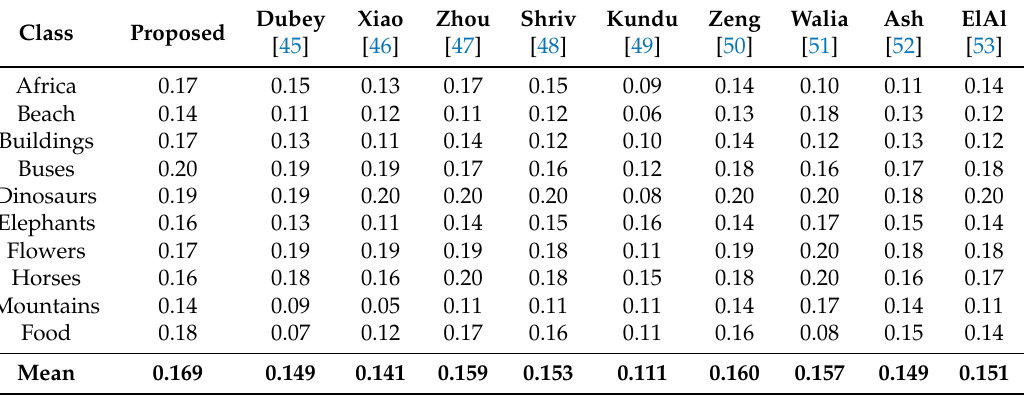
Table 3. Comparison of average recall obtained by proposed method with other standard retrieval systems on top 20